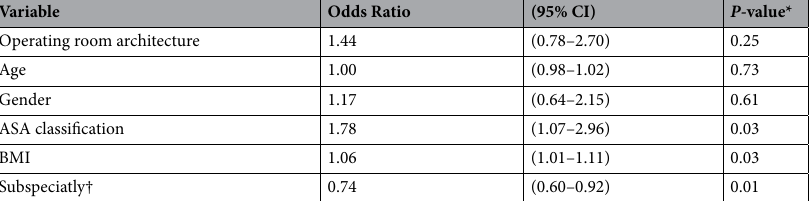
Table 2. Surgical site infection in the open- vs closed-plan operating room architecture with subspecialties. % percent, CI confidence interval, ASA American society of anesthesiologists, BMI body mass index. *Logistic regression analysis. † The subspecialty was categorized from the most common to the least common infection rate (as shown in the results section of the second